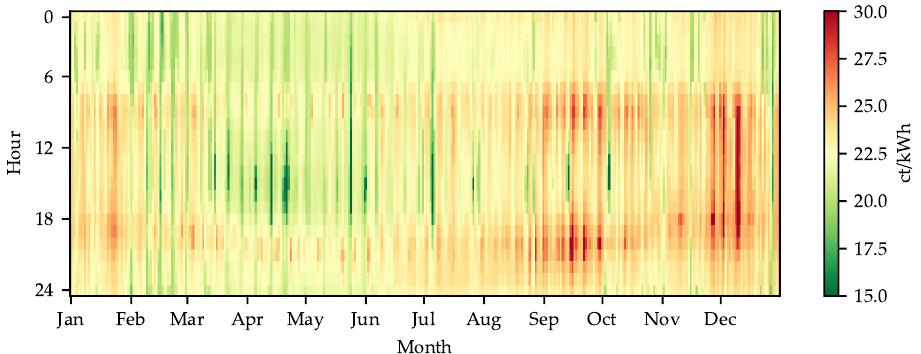
Figure 5. Heatmap of hourly electricity prices in ct/kWh during the year 2020. Extreme values outside the interval 15 ct/kWh ≤ c ≤ 30 ct/kWh are not shown (outliers see Figure 7). Table 1. Yearly average of: Intraday mean price depending, intraday price spread, and intraday MAD depending on the type of day, calculated from historic price data of the year 2020 in ct/kWh. Mon Tue Wed Thu Fri Sat Sun